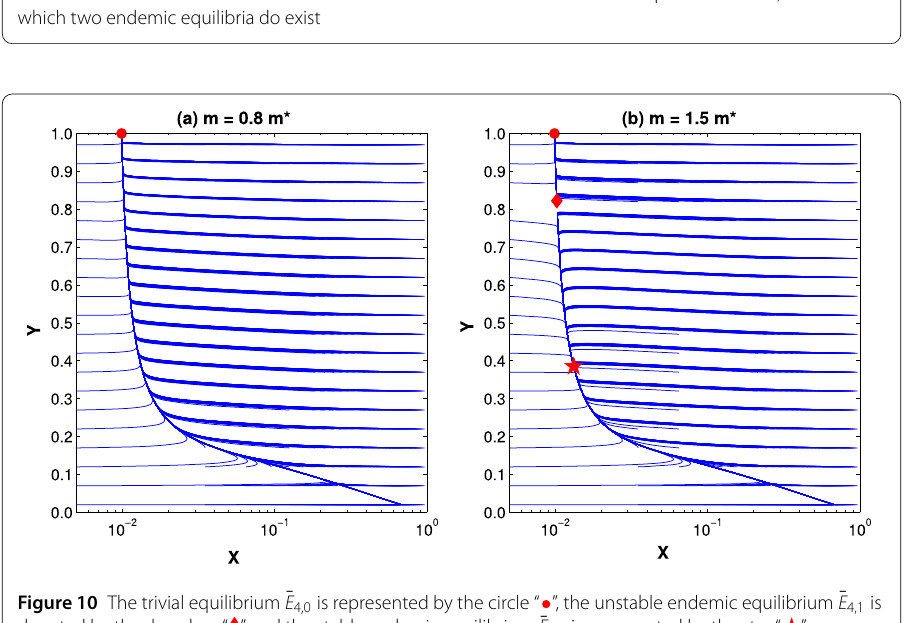
Figure 10 The trivial equilibrium ¯ E 4,0 is represented by the circle “ ”, the unstable endemic equilibrium ¯ E 4,1 is denoted by the rhombus “ ” and the stable endemic equilibrium ¯ E 4,2 is represented by the star “ ”. Simulations have been done with parameter values λ = 10, μ = 0.1, β = 0.5, γ = 0.1, h = 60, p = 3, and L = 100. Part ( a ) is produced with m = 0.8 m (cid:6) , while part ( b ) is produced with m = 1.5 m (cid:6) , where m (cid:6) =